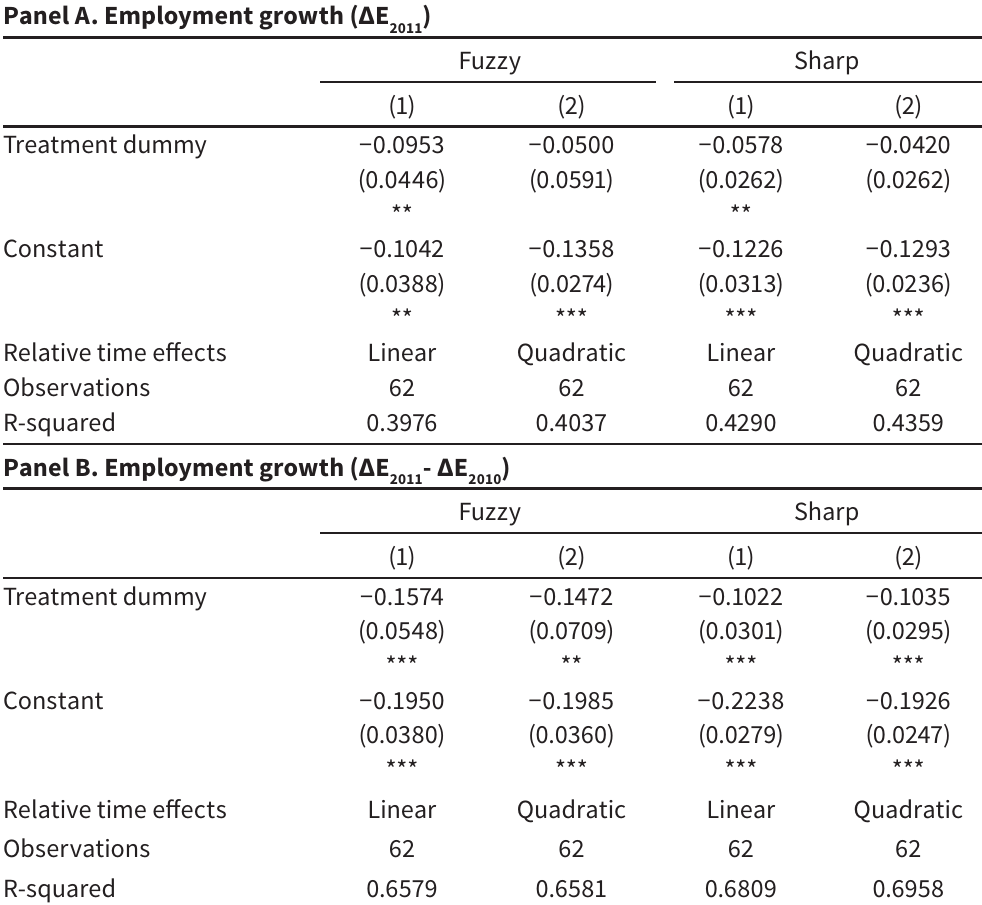
The effects of extensions, all firms Panel A. Employment growth (ΔE